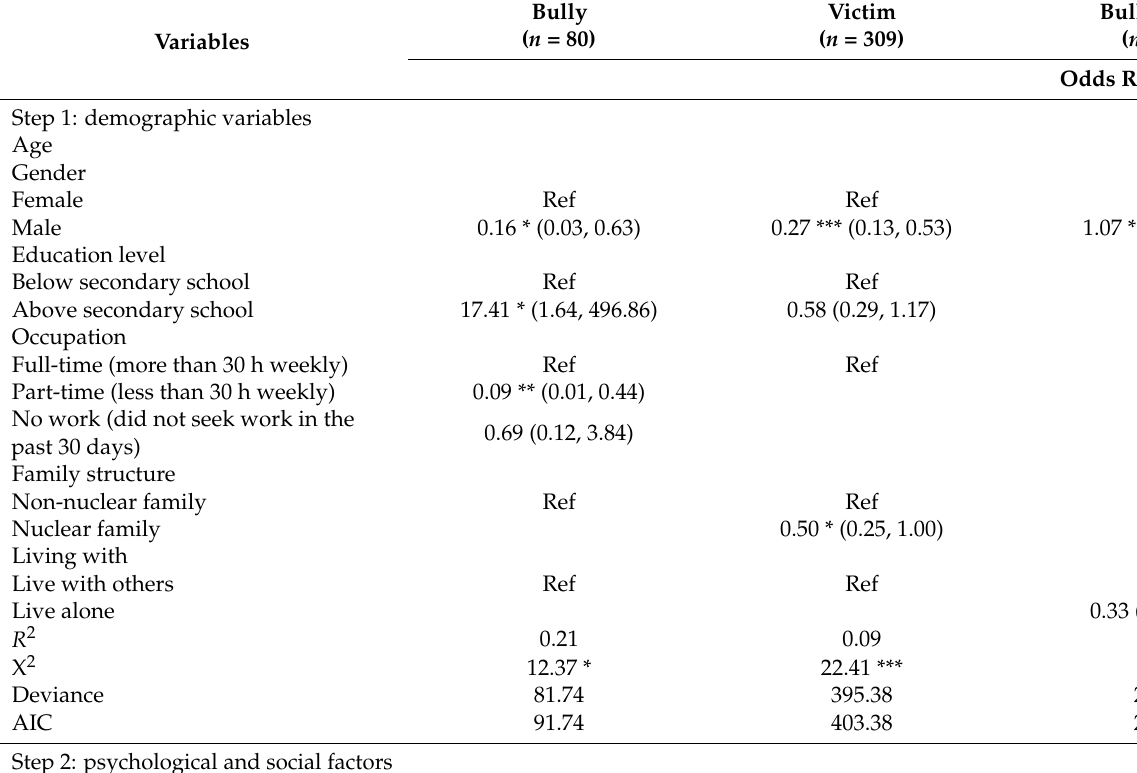
Table 5. Summary of hierarchical multiple logistic regression predicting